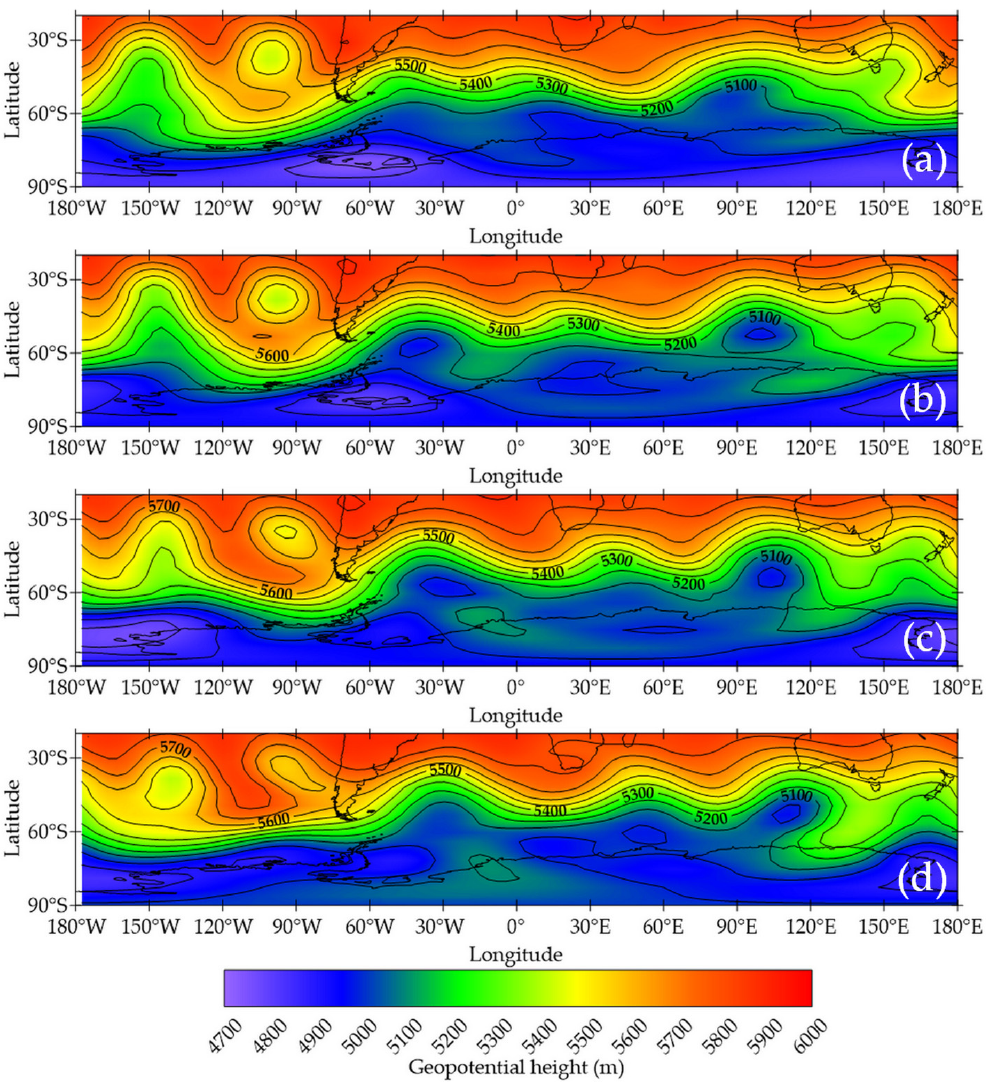
Figure 3. 500 hPa geopotential height in the SH, south of 20° S, as calculated from (1) over four consecutive days that fulfilled the blocking conditions at 95° W: ( a ) 29 June 2007; ( b ) 30 June 2007; ( c ) 1 July 2007; ( d ) 2 July 2007.